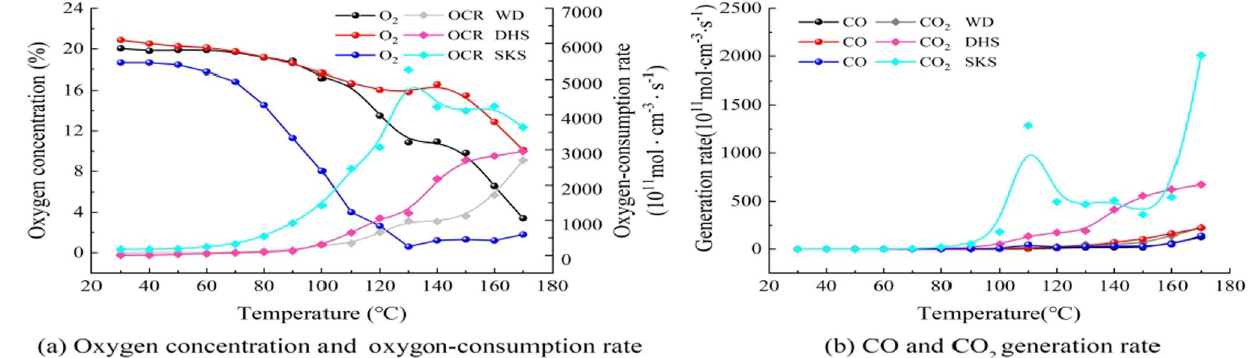
Fig. 8 Oxygen concentrations and oxygen consumption rates as a function of temperature for different coal